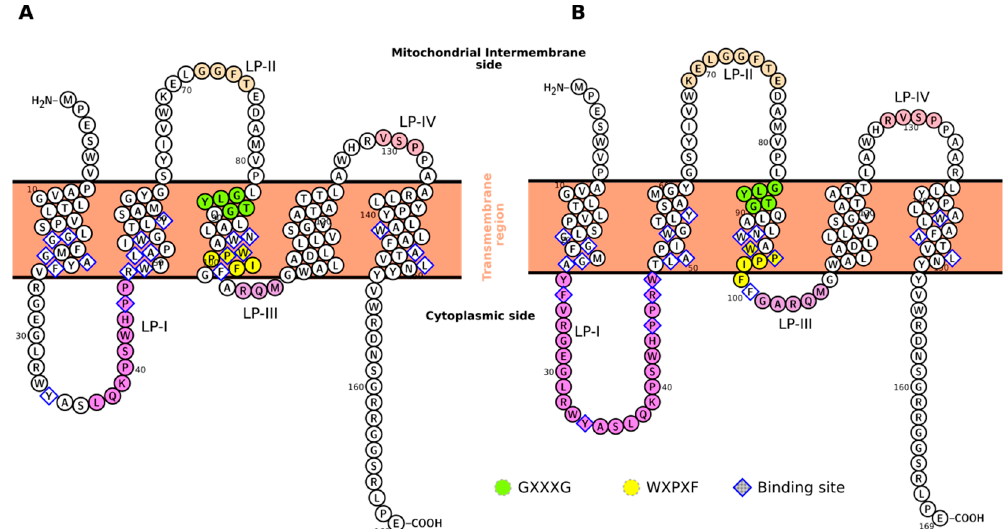
Figure 1. Topology of mTSPO for the models here considered. Specific regions and motifs discussed in the text are highlighted for mTSPO_NMR_monomer ( A ) and mTSPO_Rs_monomer ( B ). The topology is generated using the Protter web application [19].